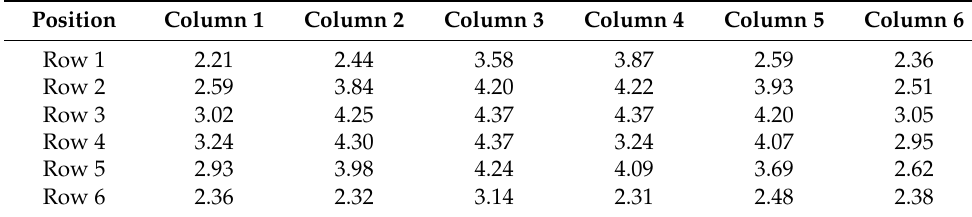
Table 3. Voltage of the photovoltaic panels.